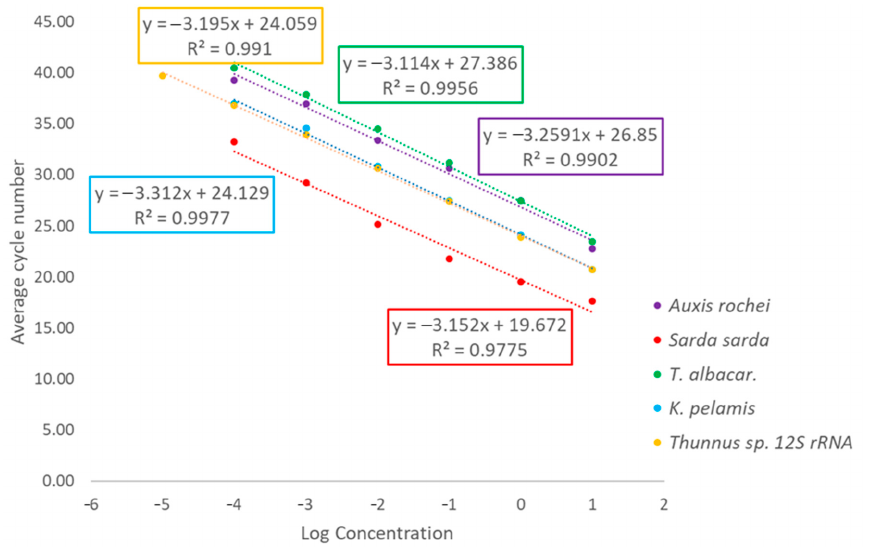
Figure 3. Mean Ct values plotted against the logarithm of the input DNA amount.